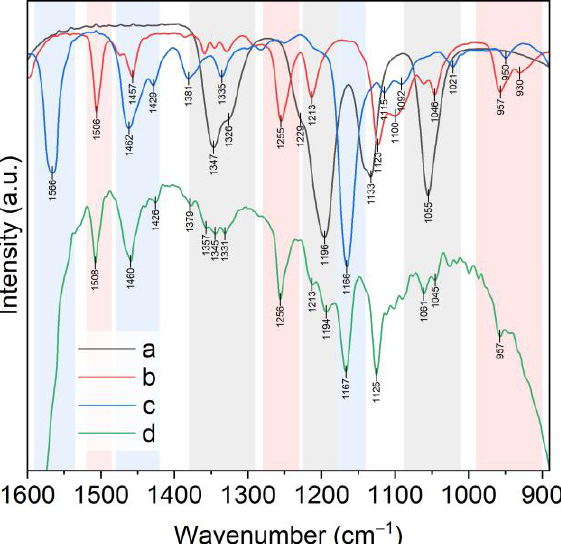
Figure 17. FTIR spectra of aqueous solutions (a) LiNTf 2 ; (b) [Li(B15C5)(H 2 O)Cl]; (c) ionic liquid [C8mim]Cl; (d) equilibrium aqueous phase of the extraction system LiCl-B15C5-[C8mim][NTf 2 ].